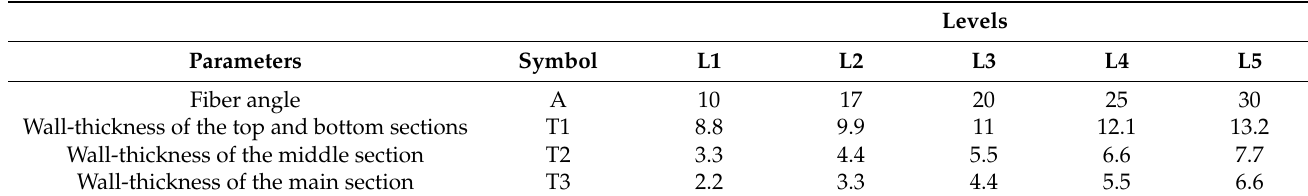
Table 3. Variables and their levels are used as input data in the response surface method (RSM).